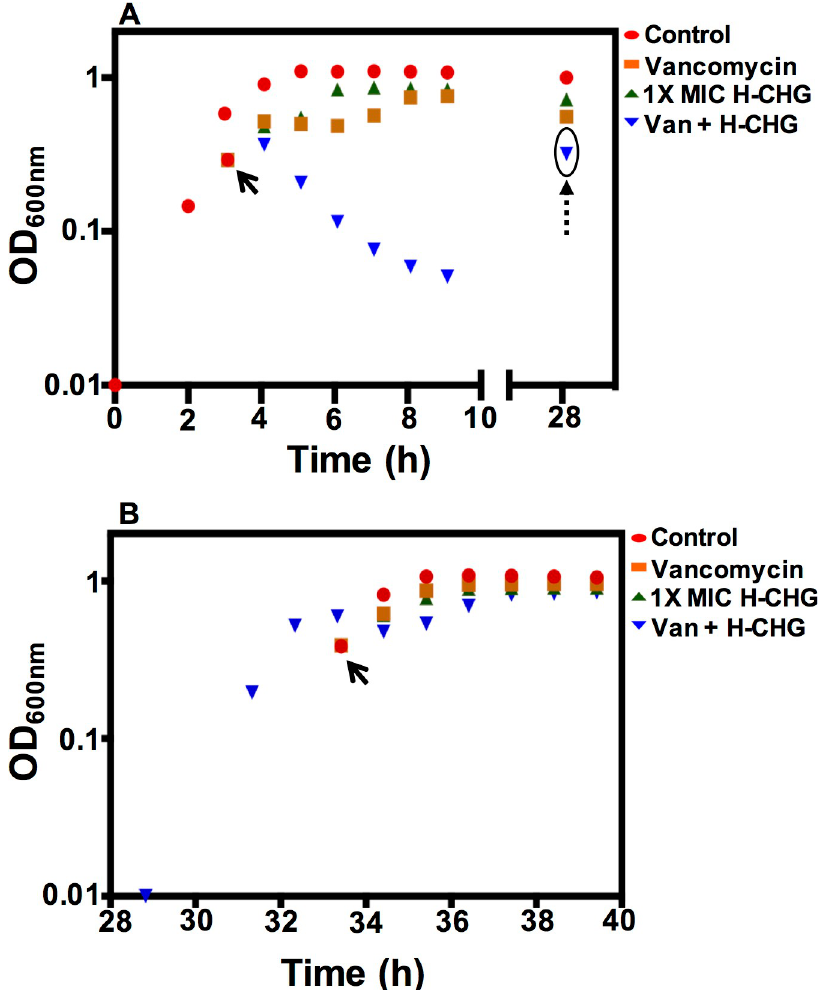
Fig 3. E . faecium 1,231,410 can adapt to vancomycin/H-CHG synergy. The growth kinetics of E . faecium 410 in the presence of vancomycin and H-CHG were observed over a two-day (40 h) growth curve. Panel (A) Representative OD 600 of E . faecium 410 after treatment with 0X (control; red circles), vancomycin (orange squares), H-CHG (green triangles) or vancomycin and H-CHG (inverted blue triangles). E . faecium culture was grown at 37˚C in BHI until OD 600 reached 0.6 and equal volumes of cultures were split into BHI with different antimicrobials (shown by arrow) as described in materials and methods. OD 600 values were monitored for 6 h and after 24 h, the vancomycin and H-CHG-treated recovered culture (circled and indicated with dashed arrow) was used as an inoculum to repeat the growth curve (shown in panel B). cytoplasm by the inner membrane channel formed by PstA-PstC. PstB energizes this channel by hydrolyzing ATP [54]. The pst system and antimicrobial susceptibility has been previously linked in E . faecium . We identified a non-synonymous substitution in phoU , a negative regula- tor of the pst operon, in a chlorhexidine-adapted E . faecium 1,231,410 derivative that had reduced chlorhexidine and daptomycin susceptibilities and decreased intracellular Pi levels [26]. We quantified the levels of intracellular inorganic phosphate (Pi) in the wild-type strain and in SE101 under routine culture conditions. However, the levels were not significantly dif- ferent for any time point assayed (S3 Fig).